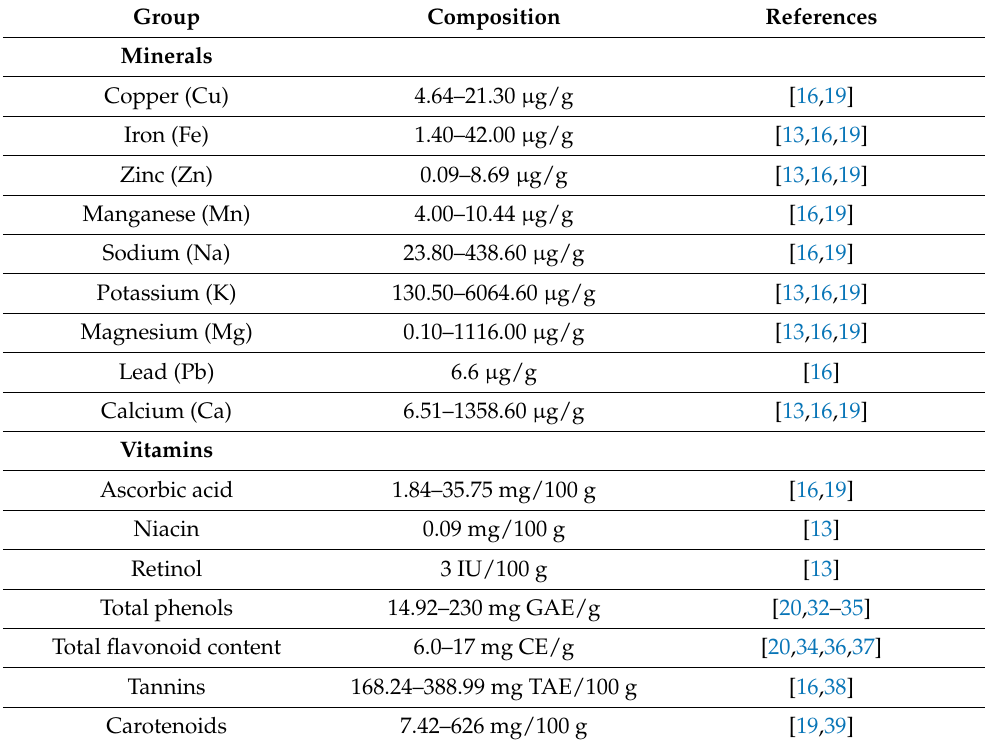
Table 2. Minerals and vitamins present in